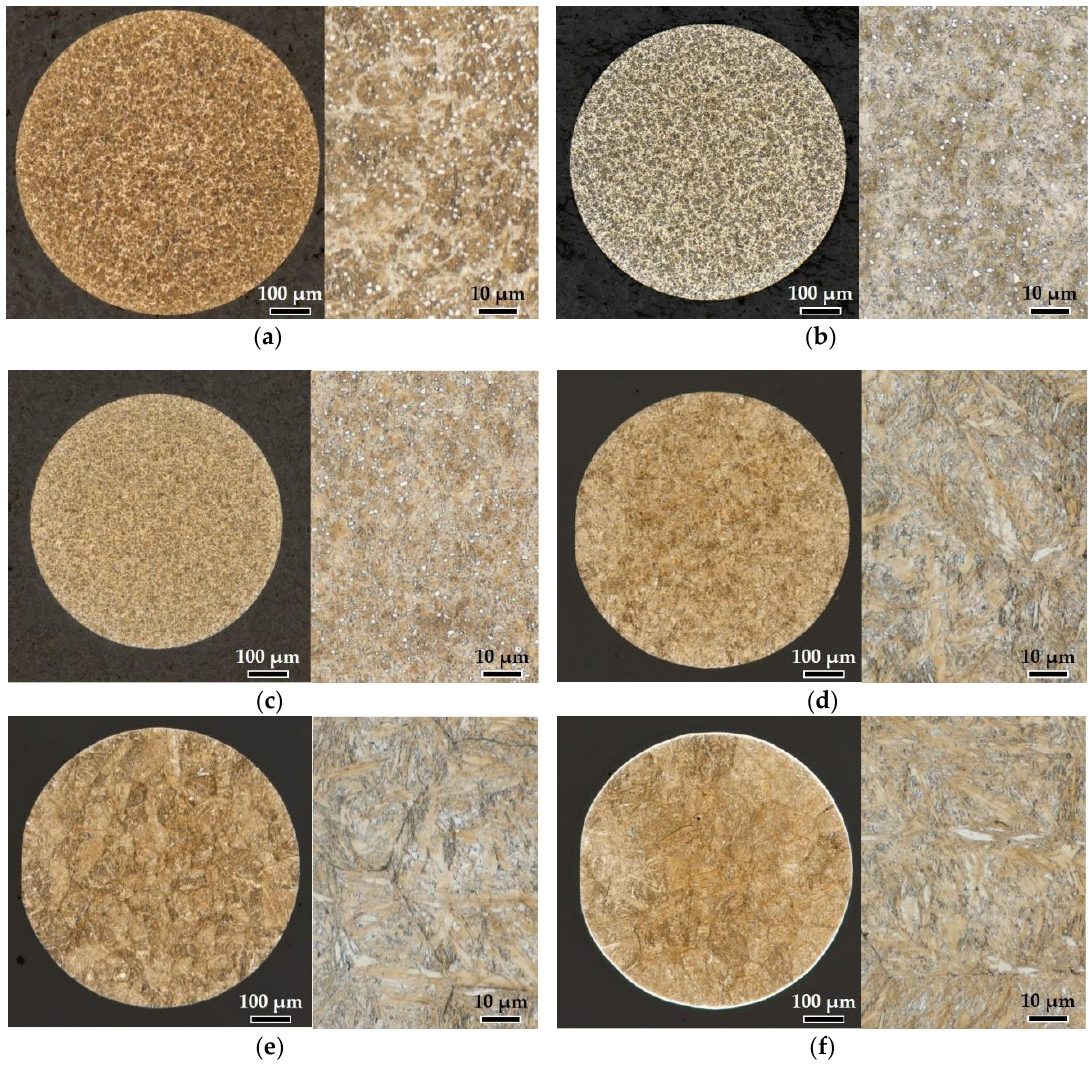
Figure 3. Metallographic microsection images in the equatorial plane of the micro samples in initial hardening conditions before DSC treatment: ( a ) Condition as bought; ( b ) Q1 with T A = 800 °C; ( c ) Q2 with T A = 850 °C; ( d ) Q3 with T A = 950 °C; ( e ) Q4 with T A = 1050 °C; ( f ) Q5 with T A = 1150 °C.